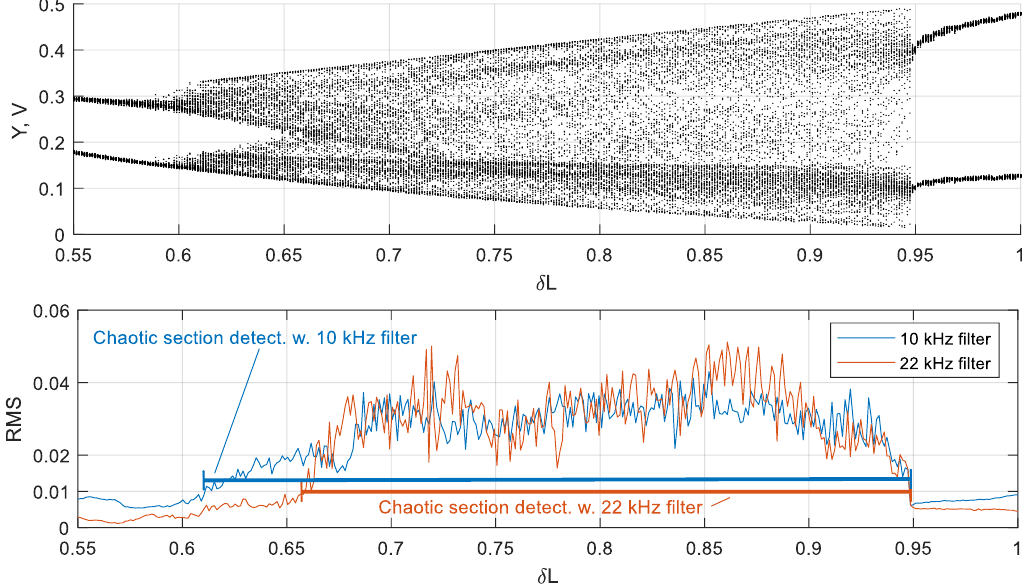
Figure 16. Comparison of the bifurcation diagram and the bandpass filter output. The strong correspondence between the non-chaotic regime and the low level of the RMS output of both filters (with 10 kHz and 22 kHz central frequencies) can be observed. Using the threshold value RMS = 0.01, the chaos can be determined.